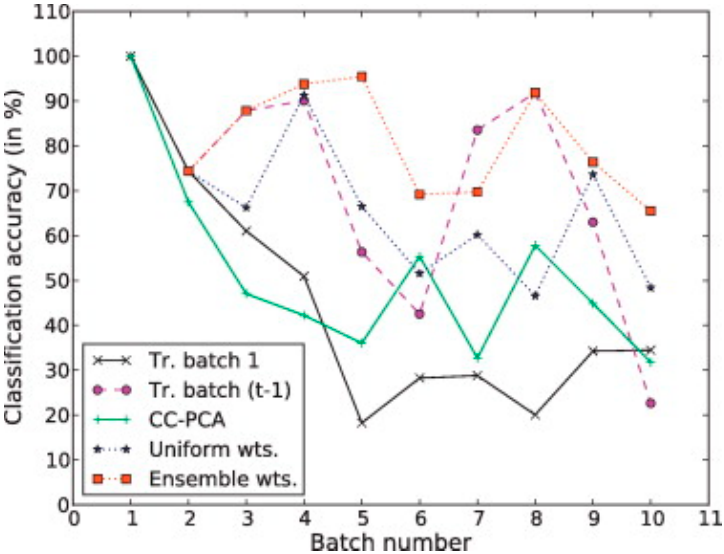
15 of 24 new data samples. The average accuracy and standard deviation of all data batches and the final data batch accuracy are compared among different methods. Vergara et al. [35] proposed the ensemble learning method with SVM classifiers to counteract sensor drift- ing. An SVM classifier was trained on each batch of newly collected data at time t, notated as (cid:1858) (cid:3047) (cid:4666)(cid:1876)(cid:4667) . To predict the data at time step t+1 , the decision was made as a weighted sum of classifiers trained previously, i.e., ℎ (cid:3047)(cid:2878)(cid:2869) = ∑ (cid:2010) (cid:3036) (cid:1858) (cid:3036) (cid:4666)(cid:1876)(cid:4667) (cid:3047) (cid:3036)(cid:2880)(cid:2869)